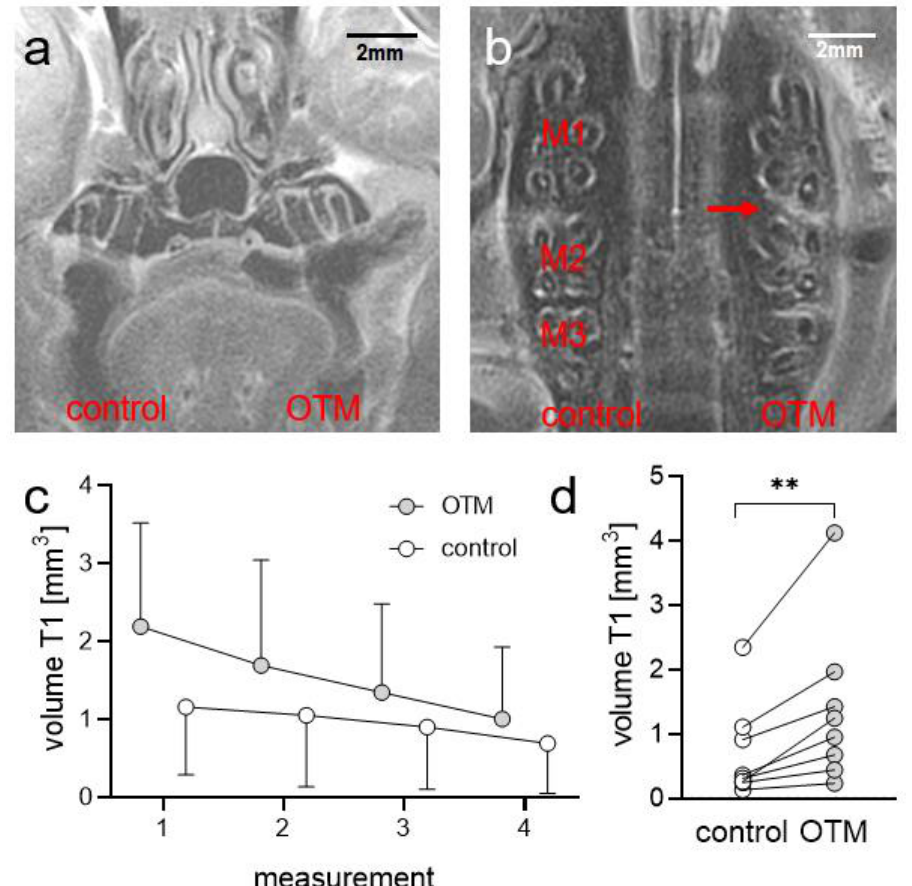
Figure 1. Representative magnetic resonance images. Frontal view ( a ) and axial view ( b ). Kinetics of T1-weighted MR images ( c ; T1 volume distally of the moved upper first left molar, n = 4). Volume of increased contrast media uptake on T1-weighted morphologic images ( d ; n = 8). Red arrow: increased contrast media uptake in T1-weighted MR image at the OTM side. OTM = orthodontic tooth movement, M1/2/3 = first/second/third upper molar. ** p < 0.01.